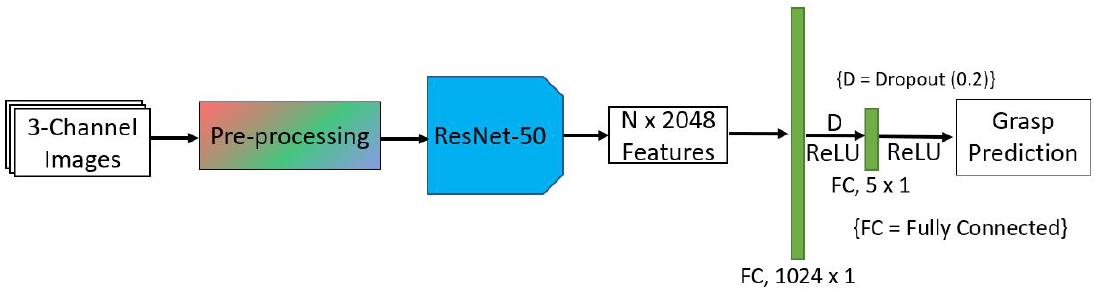
Figure 10. Uni-modal grasp predictor [10].